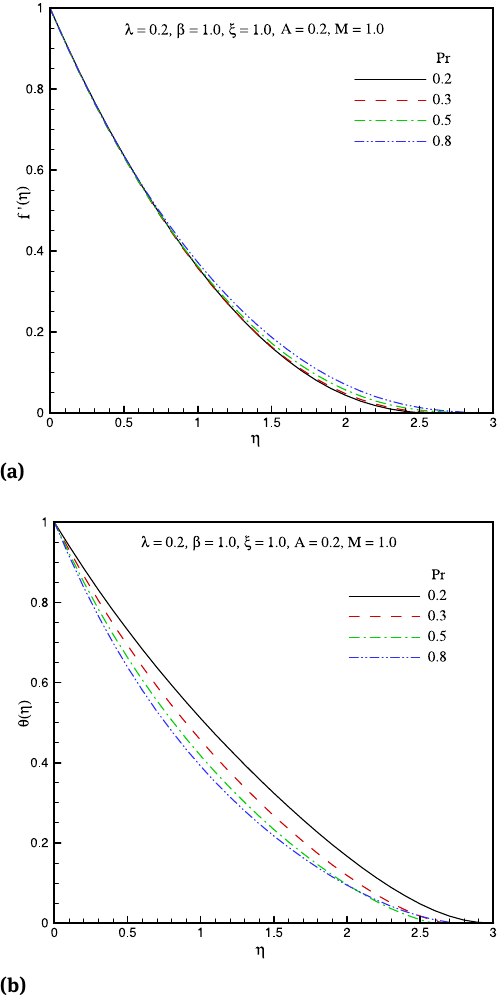
Figure 6: Simulated velocity and temperature profiles for various values of Prandtl